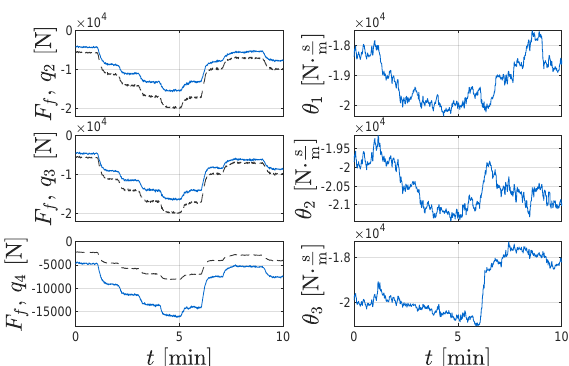
Figure 11: Case 4 frictional pressure forces and esti- mated parameter θ i . Solid blue lines denote the estimates and dashed black lines denote the true values.